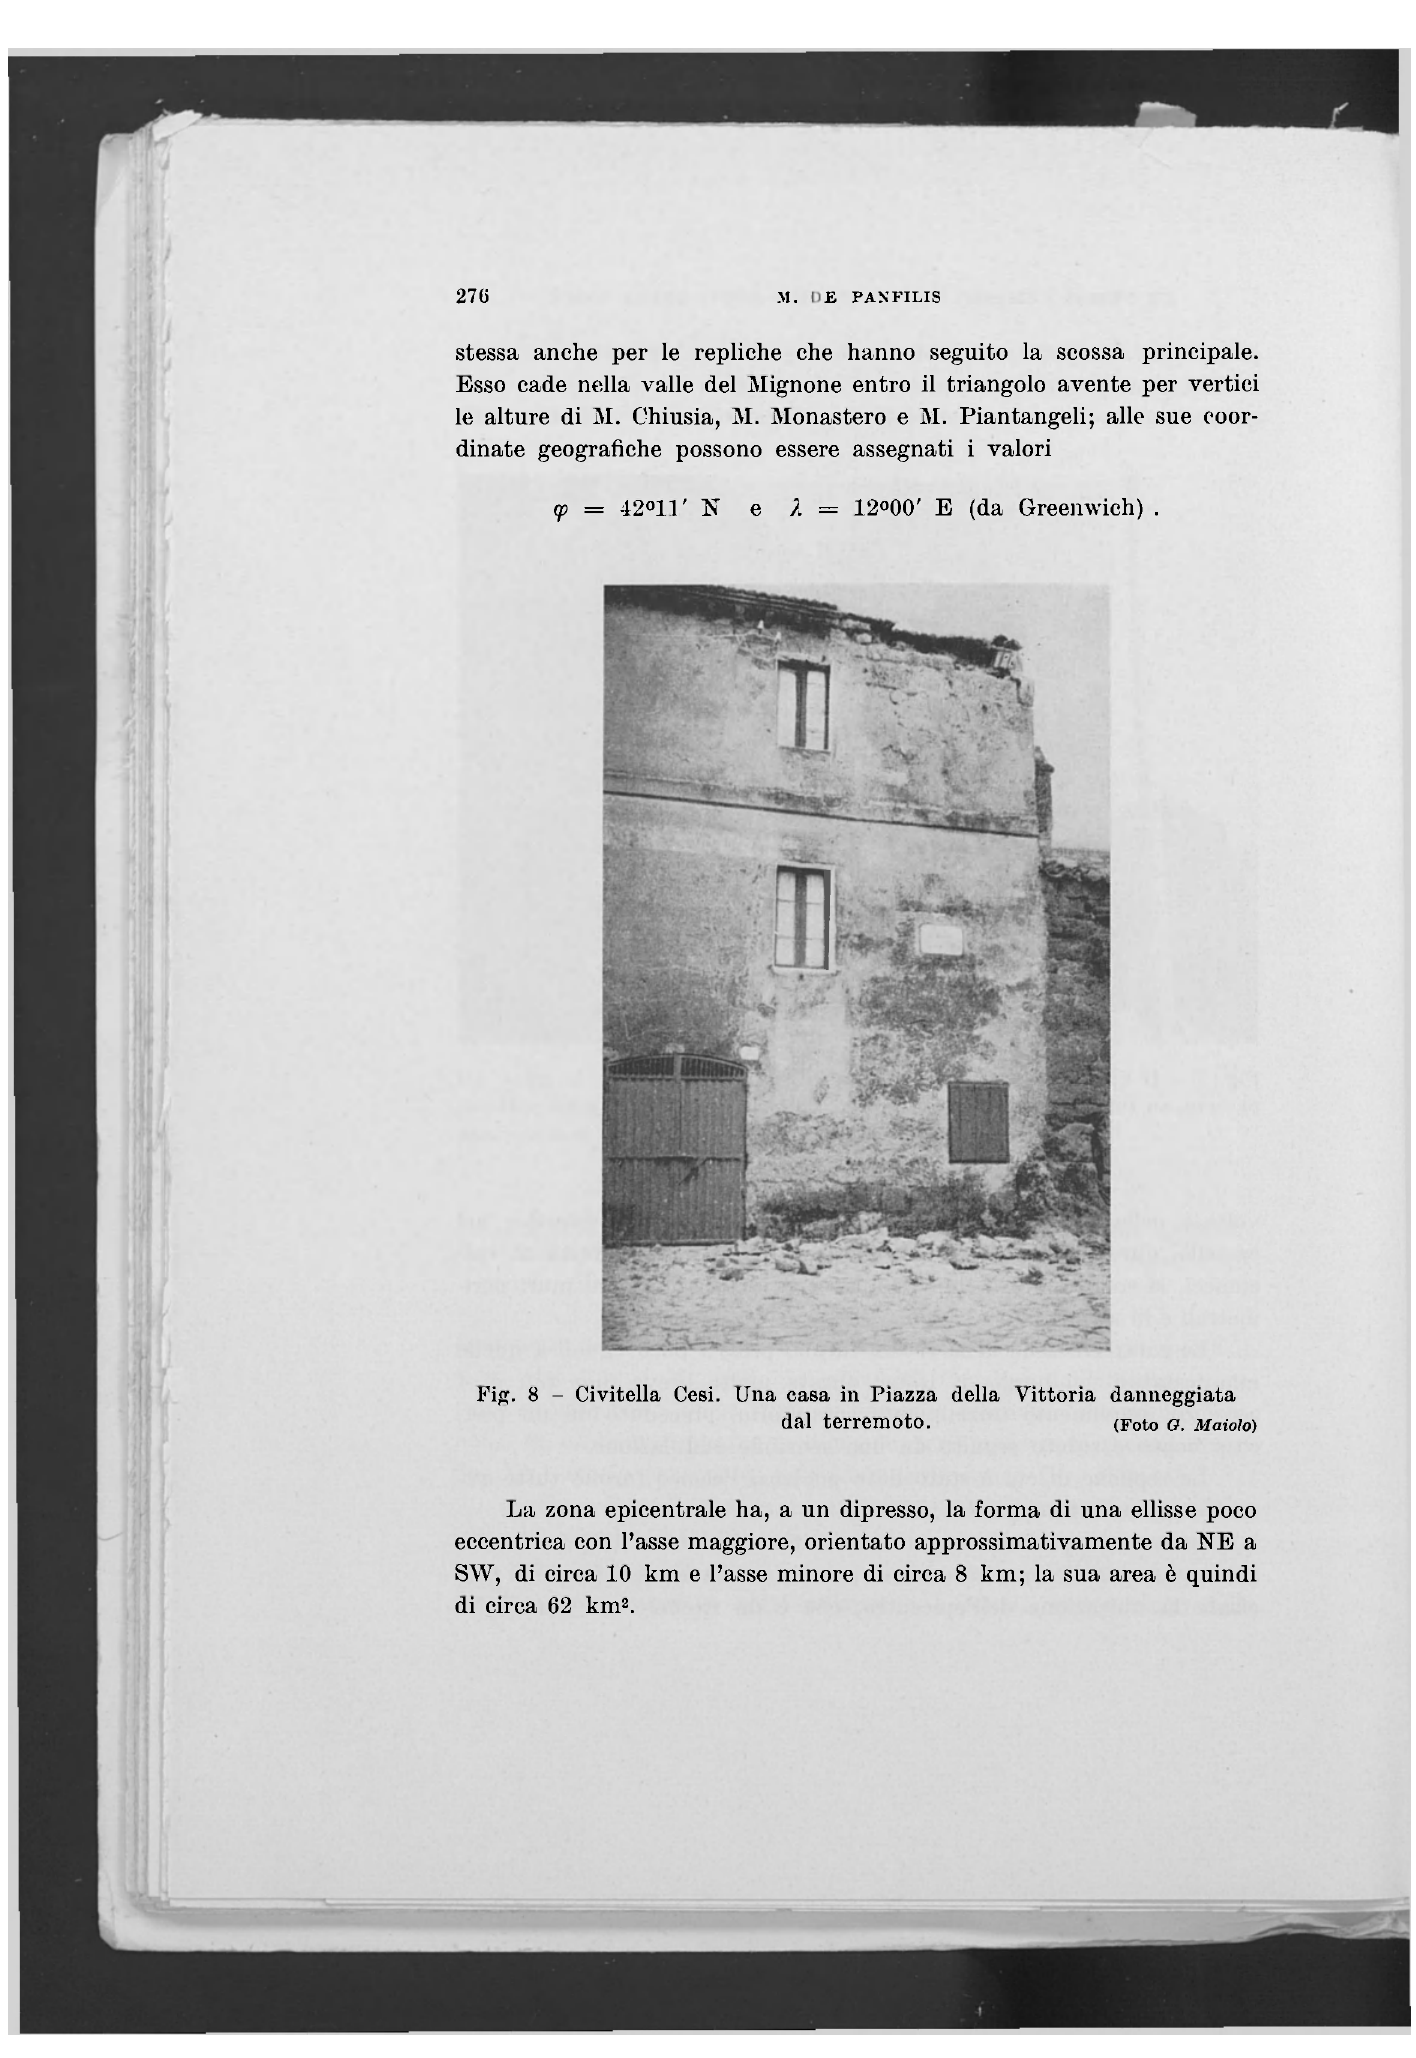
Fig. 8 - Civitella Cesi. Una casa in Piazza della Vittoria danneggiata dal terremoto. (Foto G.